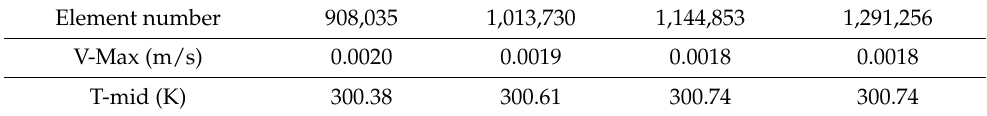
Table 3. Average panel temperature in different grids for a velocity of 0.1 cm/s. Table 4. The numerical model and Bizhaem and Abbassi [53] in the pressure drop at the Reynolds numbers of 200, 500, and 1000 for volume fractions of 1% and 3%.